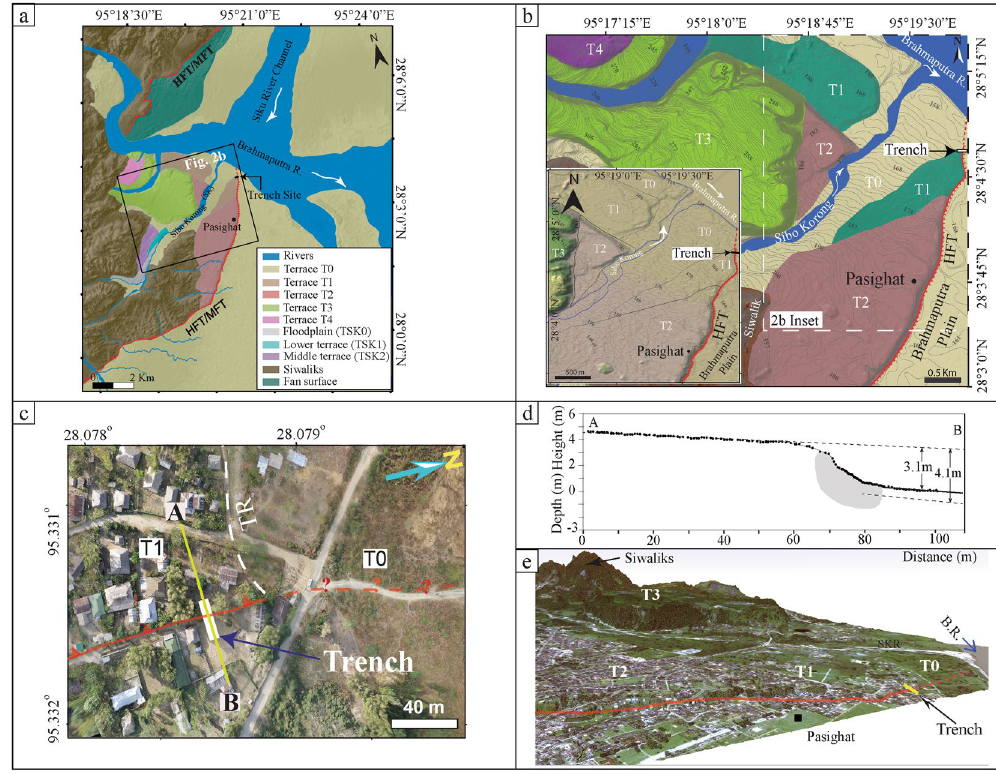
Figure 2. ( a ) Regional tectono-geomorphic map of the trench site at Pasighat prepared from Cartosat-1 satellite imagery. ( b ) Geomorphic map of Pasighat area showing different features mapped in the field aided with Pleiades satellite imagery. Inset map showing the enlarged view of the trench site. Maps were prepared using Pleiades and Cartosat-1 imageries purchased from http://www.nrsc.gov.in (Source: NRSC, ISRO/DOS) in SOCET GXP version 4.1.0 software and artwork in Adobe Illustrator CS5 software. ( c ) Figure showing the aerial photo-mosaic of specified view of the Pasighat trench site obtained using Ricoh GR 8.3 megapixel digital camera mounted at the bottom of UAV (DJI Phantom 1 multi-rotor cod copter); for field photograph of the trench site refer to Fig. S1a; mosaic was made using AgiSoft Photo Scan Pro software purchased from http:// www.agisoft.com ( d ) RTK-GPS profile of the Pasighat scarp showing the excavated trench (grey polygon) prepared in Leica Geo Office v7.0 programme and artwork in Adobe Illustrator CS5 software; Scarp height is 3.1 m (when measured as the vertical difference between the sloping profile across the scarp) and 4.1 m (when measured as the vertical separation between the sloping profile of the hangingwall and the event horizon) in the footwall. Location of profile A-B is shown in Fig. 2c. Microtopographic map of the trench site is provided in Supplementary Figure S1d. ( e ) 3D perspective view of the Pasighat trench site generated using Pleiades Digital Elevation Model (DEM) in Global Mapper v15.0 software. Model shows different terrace levels; fault scarp (red line), trench (yellow